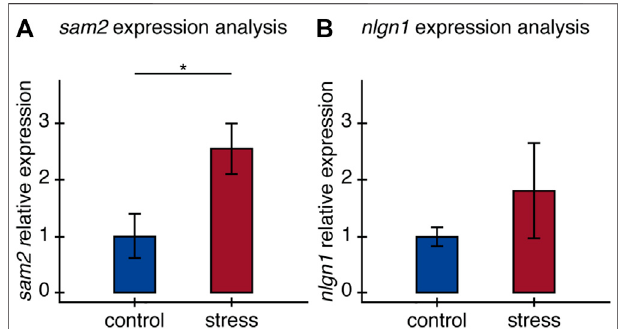
FIGURE 4| Relative expression of (A) sam2 and (B) nlgn1 in the brain of old fi sh. Relative expression of sam2 and nlgn1 between control and stress groups, calculated as fold-change differences in expression to the average expression of two housekeeping genes All results are expressed as the mean ± standard error: * p <